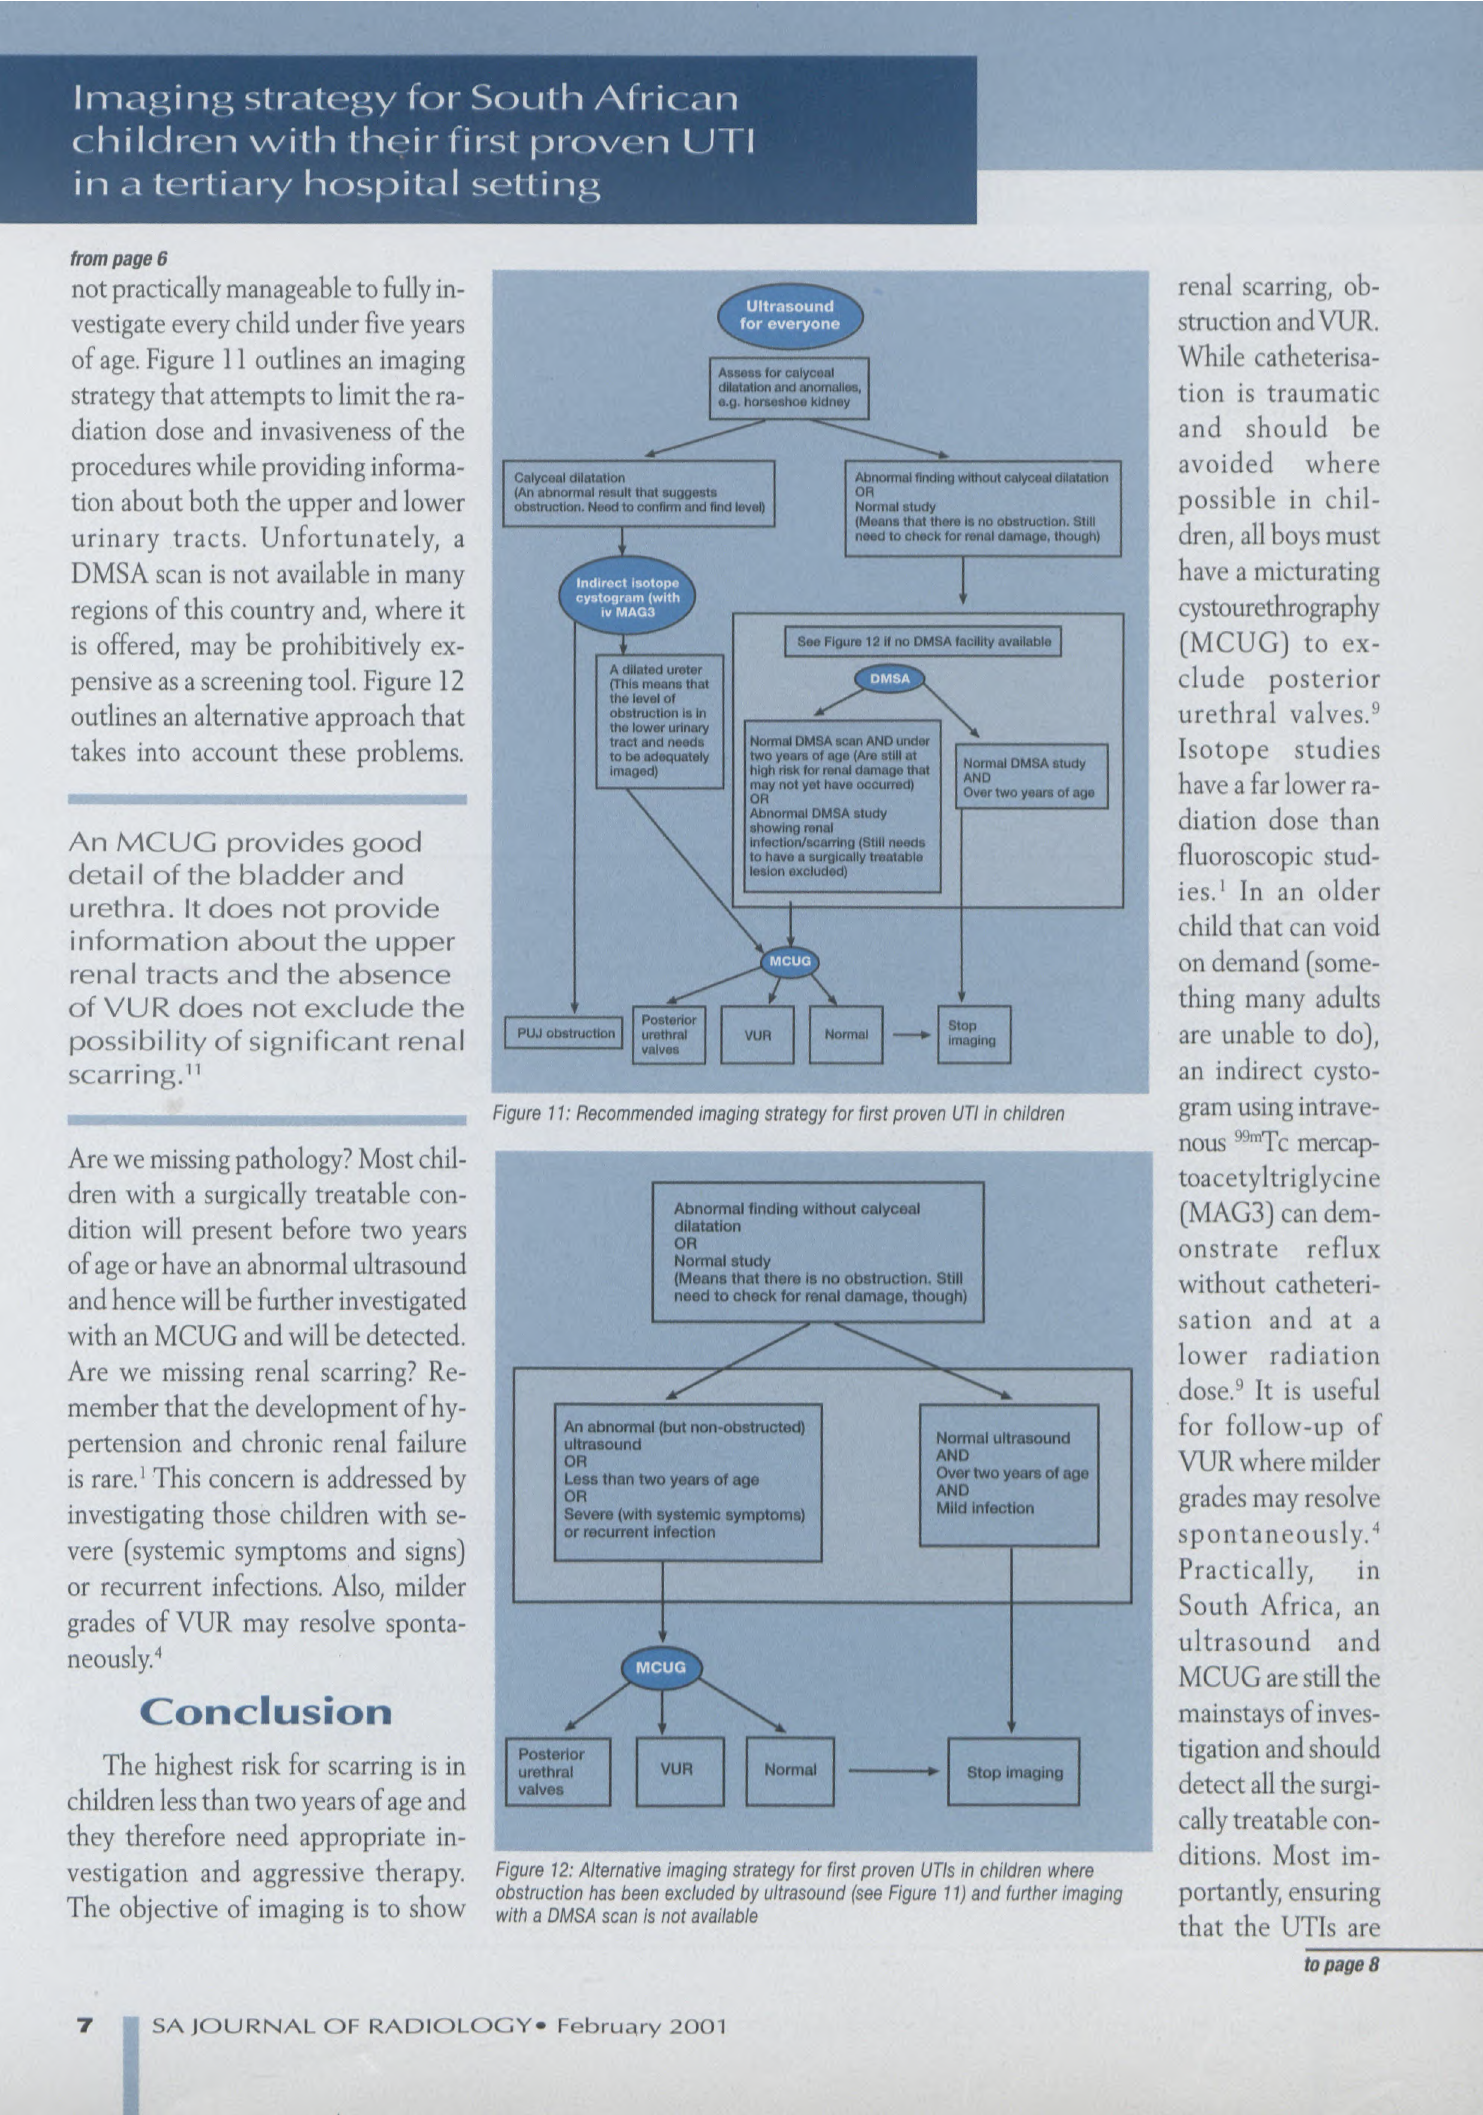
Figure 12: Alternative imaging strategy for first proven UTis in children where obstruction has been excluded by ultrasound (see Figure 11) and further imaging with a DMSA scan is not